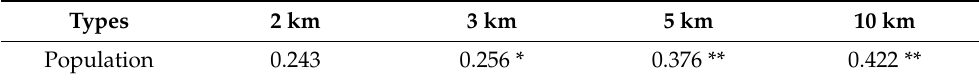
Table A4. Correlation coefficients between population and PM 2.5 concentration at different buffer